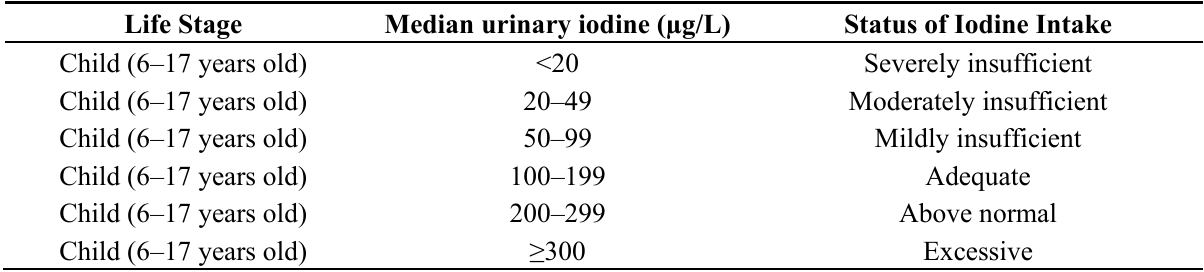
Table A6. Iodine status of children 6–17 years of age based on median urinary iodine